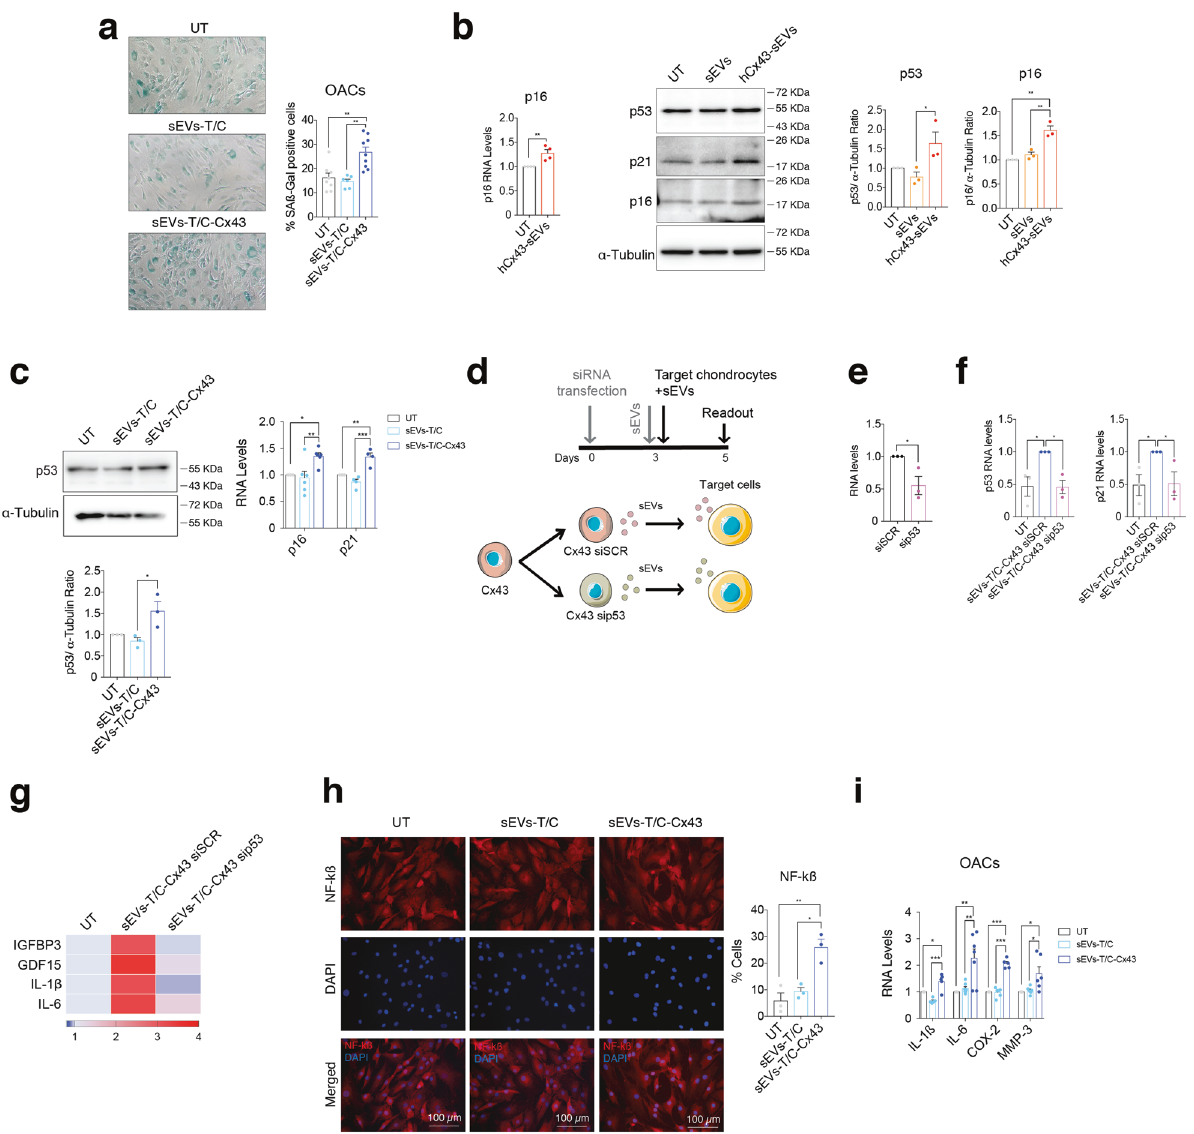
Fig. 4 Exosomal Cx43 promotes a senescence in fl ammatory phenotype in target chondrocytes. a Treatment of OA-derived chondrocytes with sEVs derived from Cx43-overexpressing T/C-28a2 chondrocytes (sEVs-T/C-Cx43) for 48 h increased the number of senescence-associated β -galactosidase (SA- β -Gal) positive cells. n = 6 – 9, one-way ANOVA. b The gene expression levels of the senescence marker p16 gene ( n = 4, Student ’ s t test), as well as the protein levels as p53 ( n = 3, one-way ANOVA), p21 ( n = 2) and p16 ( n = 3, one-way ANOVA) markers were upregulated in OA-derived chondrocytes after a 48-h treatment with sEVs derived from Oligo-treated OA-derived chondrocytes (hCx43-sEVs). c The treatment of OA-derived chondrocytes with sEVs derived from Cx43-overexpressing T/C-28a2 chondrocytes (sEVs-T/C-Cx43) for 48 h lead to increased p53 protein levels ( n = 3, one-way ANOVA) and the gene expression of p16 ( n = 5, one-way ANOVA) and p21 ( n = 4, one-way ANOVA). d Schematic representation and timeline followed for siRNA transfection in Cx43-overexpressing T/C-28a2 chondrocytes. siRNA targeting p53 (sip53) and a siRNA control (siSCR) were transfected into the Cx43-overexpressing T/C-28a2 cell line. sEVs were collected 72 h after transfection and immediately used to treat primary chondrocytes for 48 h. e P53 RNA-analysis in sip53 knockdown in T/C28a2 chondrocytes overexpressing Cx43, compared to siSCR in the same cell type. n = 3, Student ’ s t test. f RNA expression levels of p53, p21 in OA primary chondrocytes after treatment with sEVs for 48 h. g Heatmap showing the expression levels of different p53-targets and NF-kB SASP factors after sEVs treatment for 48 h, n = 3. h sEVs derived from Cx43-overexpressing T/C-28a2 chondrocytes (sEVs-T/C-Cx43) promoted NF-k β activation in OA-derived chondrocytes, as detected by the increased number of nuclear NF-k β positive cells. n = 3, one-way ANOVA. i RNA expression analysis of different SASP components showed upregulation in OA-derived chondrocytes after 48-h treatment with sEVs-T/C-Cx43. n = 4 – 7, one-way ANOVA. Data are expressed as mean ± S.E.M., * P < 0.05, ** P < 0.01, *** P < target of rapamycin (mTOR) protein, as well as its activator as well as upregulation of UPR pathways as an attempt to LAMTOR1, were only detected in sEVs-T/C-Cx43 (Table S2). counteract the proteostasis imbalance [32]. In addition, chronic ER Remarkably, mTOR, which acts as a positive SASP regulator stress has been associated with OA [33, 34]. We also observed the [36 – 38], is overexpressed in OA cartilage, and mTOR ablation was presence of ubiquitin-speci fi c protease USP10 (Tables S2, S3, S6), correlated with increased autophagy and protection from involved in DNA-damage response, maintenance of genomic cartilage degeneration in OA animal models [39]. Matrix stability and NF-kB activation [35]. Importantly, the mammalian